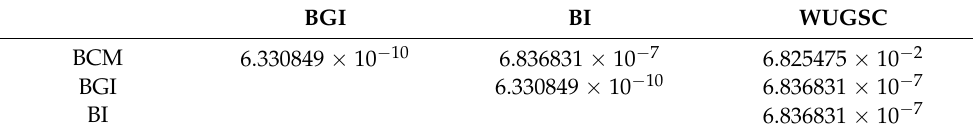
Table 7. p -values from Wilcox tests between the different sequencing centers for the FIN population.